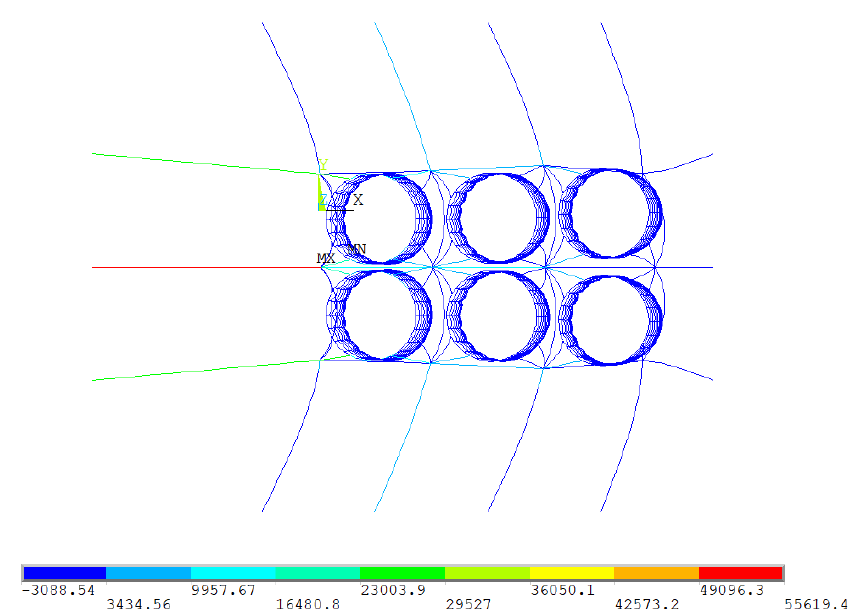
Figure 4. The instantaneous axial force distribution, unit: N. (current velocity = 0.5 m/s, wave height = 1 m, wave period = 10 s, time = 120 s).